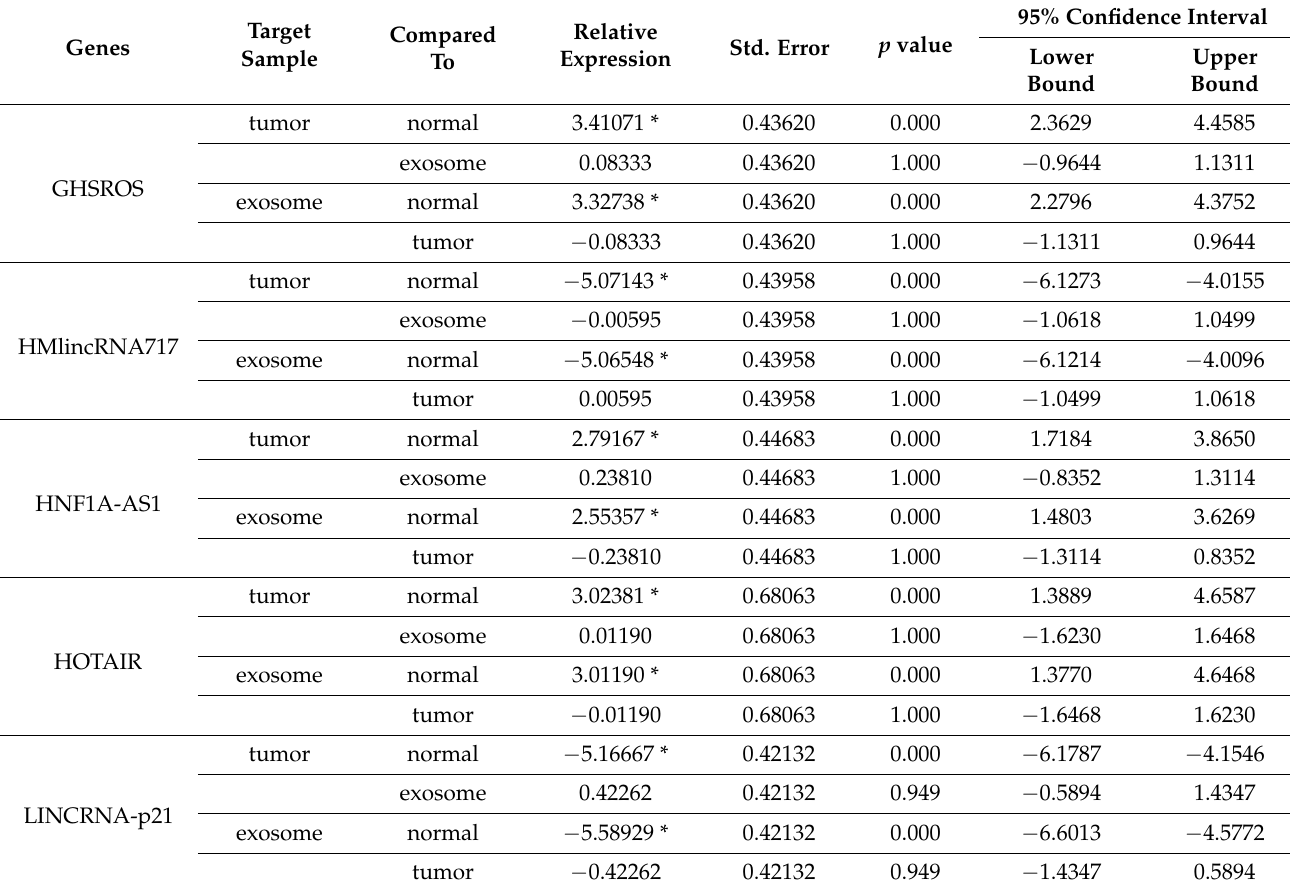
Figure 3. Relative expression of different lncRNAs in different tissues. Table 3. Comparison of relative expression of lncRNAs in different tissues.